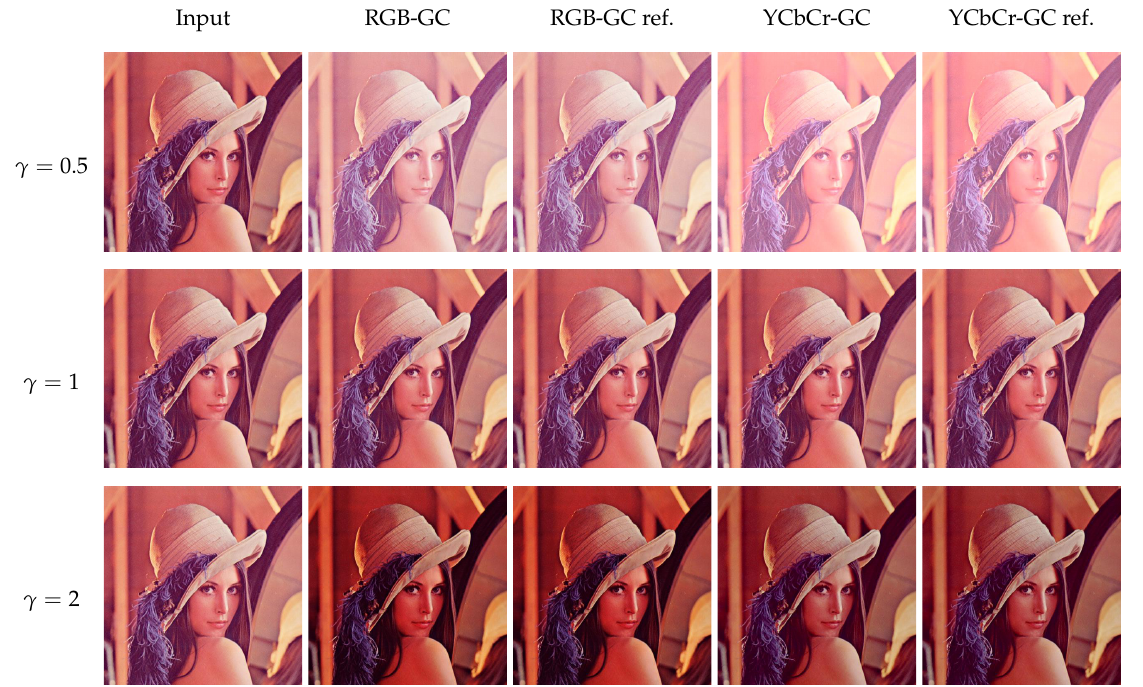
Figure 11. Qualitative comparison of the RGB-GC, YCbCr-GC, and their corresponding floating-point